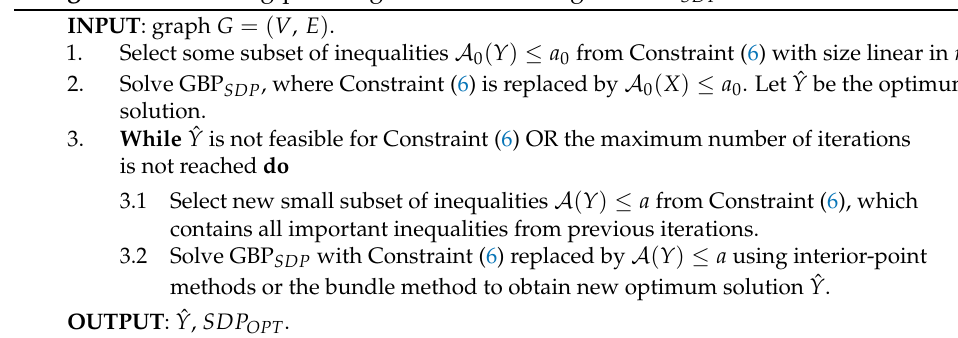
Algorithm 2: Cutting-plane algorithm for solving the GBP